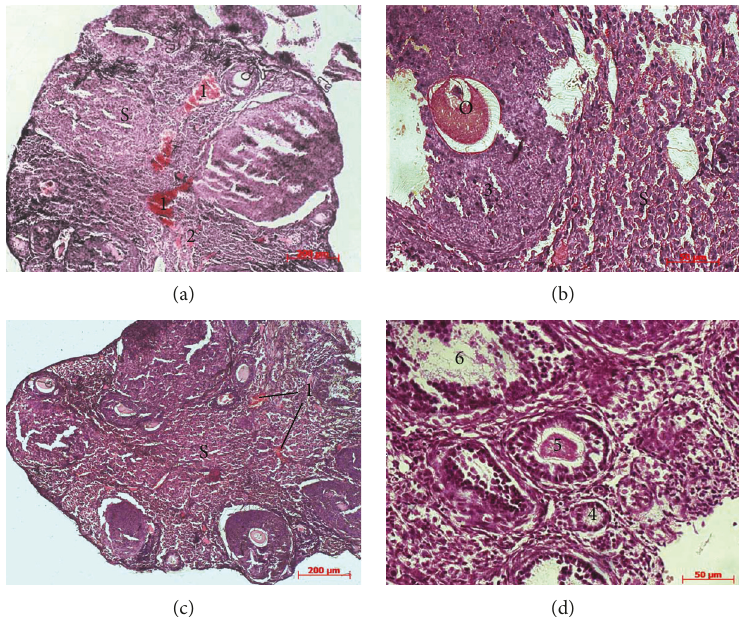
Figure 5: Histological sections of the ovaries on the 21st day of experiment. (a), (b) After saline administration: Primordial and primary follicles were not available; the extensive area of ovaries was fi lled with stroma (S) in which the full-blooded capillaries (1) and hemorrhages (2) were determined. Granulosa cells (3) were compressed, separated, and were less adjacent to oocyte (O). (c), (d) After cMSC administration: The follicular pro fi le was characterized by the presence of primordial (4), primary (5), and preantral (6) follicles. Hematoxylin and eosin staining.